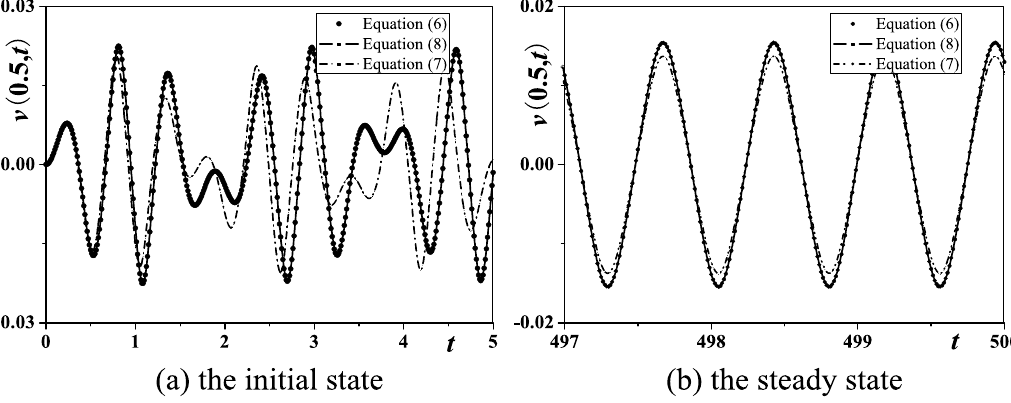
Fig. 1. The time history calculated from three models in the first resonance.